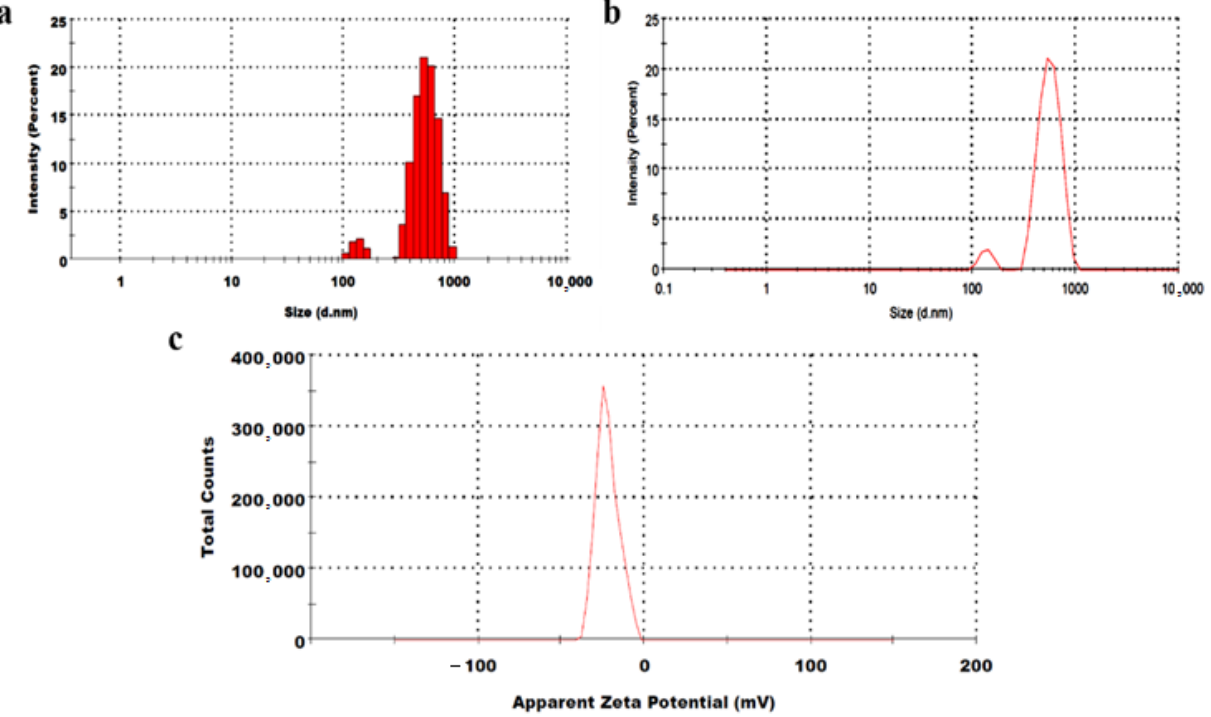
Figure 2. Images of optimized nanosponge IBNS4: particle size distribution ( a ), particle size ( b ), and zeta potential ( c ).